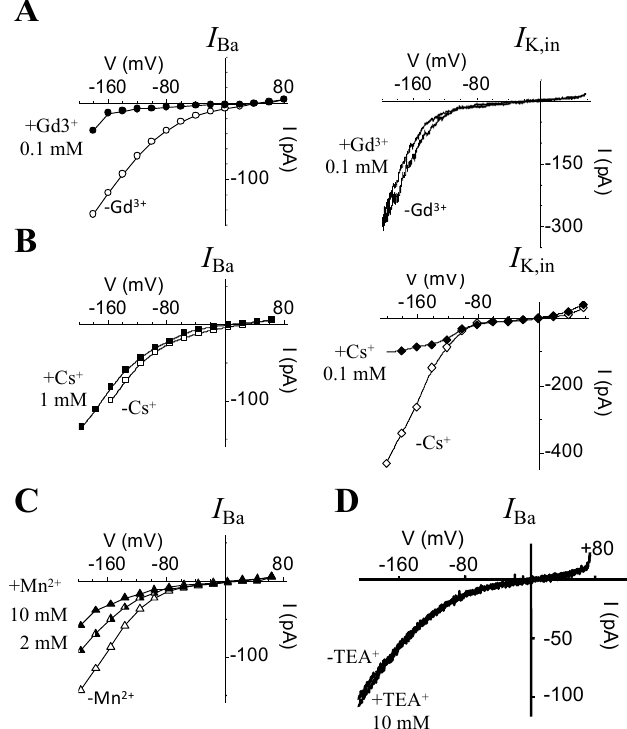
Figure 4. Differential effects of some known blockers on the two main PM conductances activated by hyperpolarization in guard cells, namely I Ba and I K,in . ( A ) I-V plots showing the effect of Gd 3+ (0.1 mM) on I Ba (left panel) and I K,in (right panel). ( B ) I-V plots showing the effect of 1 mM Cs + on I Ba (left panel) compared to the effect of 0.1 mM Cs + on I K,in (right panel). ( C ) I-V plot showing the effect of Mn 2+ on I Ba recorded from the same GCP using 2 and 10 mM in the bath. ( D ) I Ba -V plots generated from current recordings using hyperpolarizing ramps (+64 to − 196 mV; 0.7 V.s − 1 ; h v = − 36 mV), showing the effect of 10 mM TEA + added to the bath.